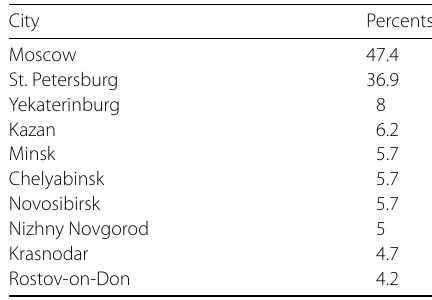
Table 12 Distribution of the most common cities identified in the overall data sample